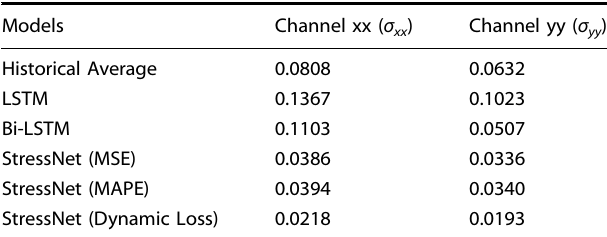
Table 3. Performances comparison among different models by using